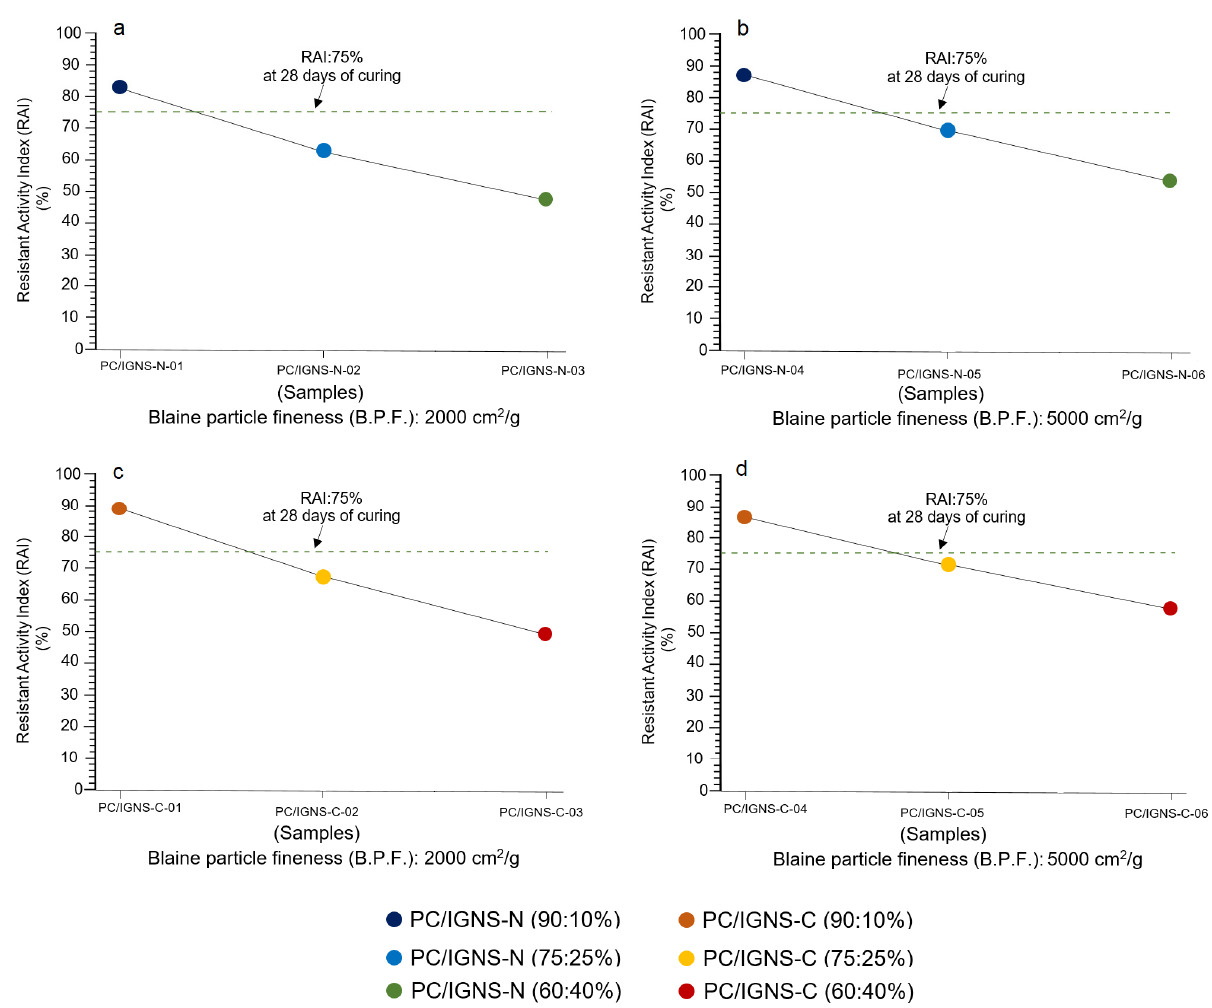
Figure 8. Variation of the Resistant Activity Index (RAI) in mortar specimens formulated with mixtures of Portland cement (PC) and ignimbrite (PC/IGNS) in natural state ( a , b ) and calcined ( c , d ), and with B.P.F. of the IGNS of 2000 and 5000 cm 2 /g, respectively. RAI was calculated for 28 days of curing.